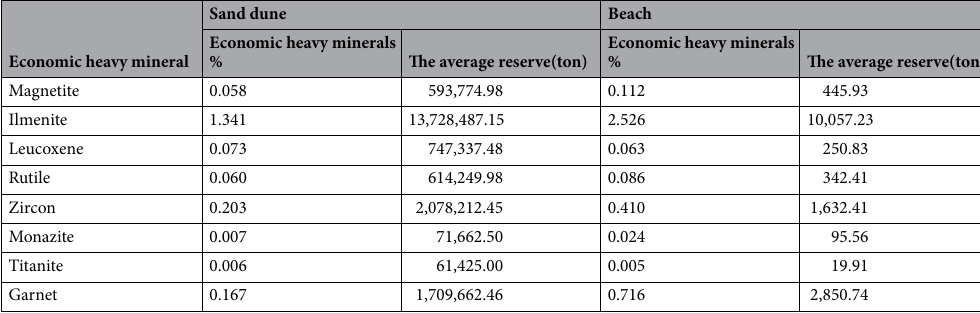
Sand dune Beach Economic heavy minerals Economic heavy mineral % The average reserve(ton)